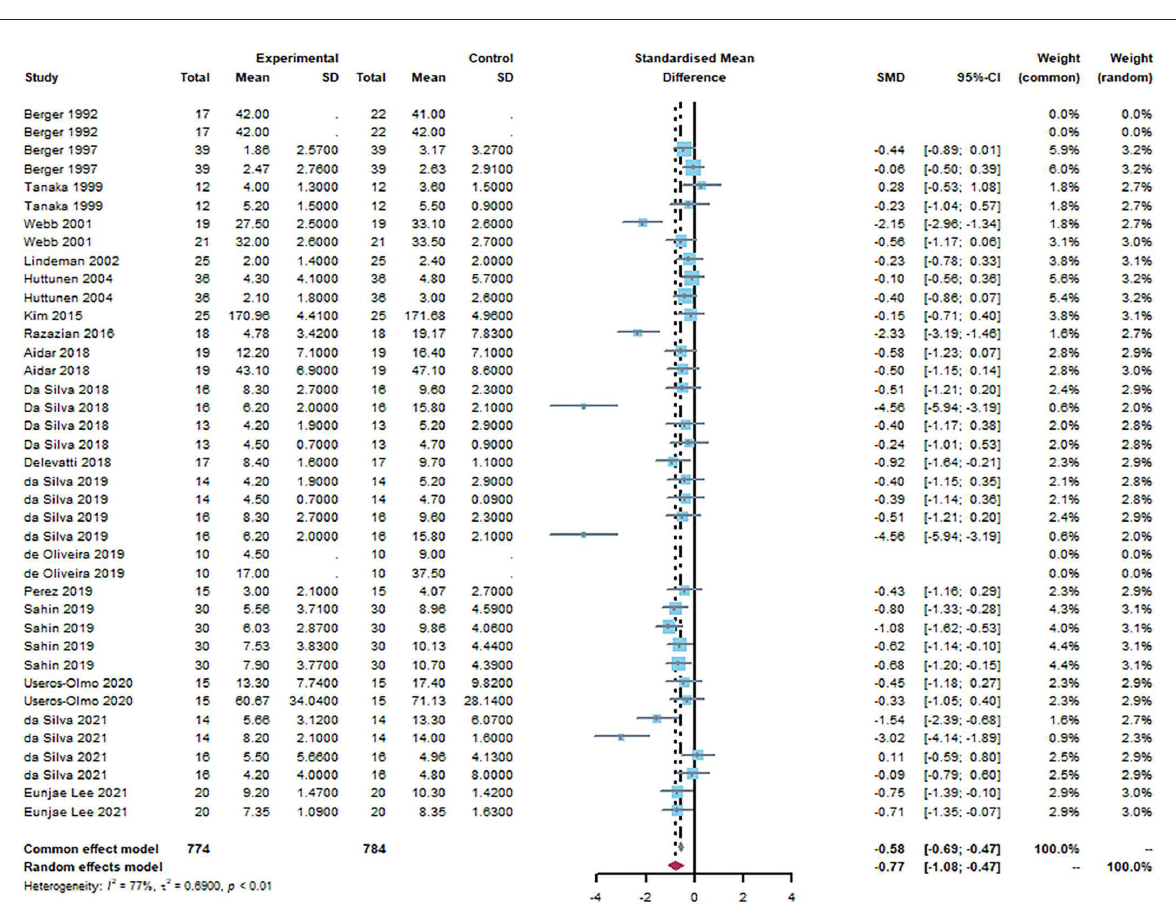
FIGURE4 Forest plot of aquatic exercise effects on mood. The overall effect of aquatic exercise: [SMD = − 0.77, 95% CI ( − 1.08, − 0.47), I2 = 77%, P <